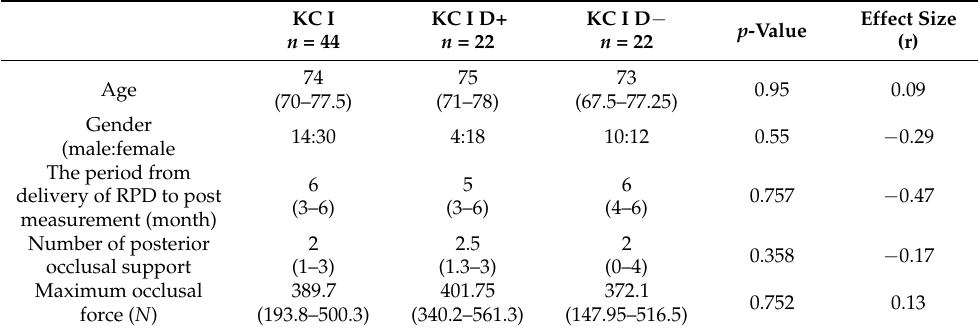
Table 1. Summary of patients’ profiles (median and IQR). No statistical differences between KC I D+ and D − ( p > 0.05, Mann–Whitney U test).